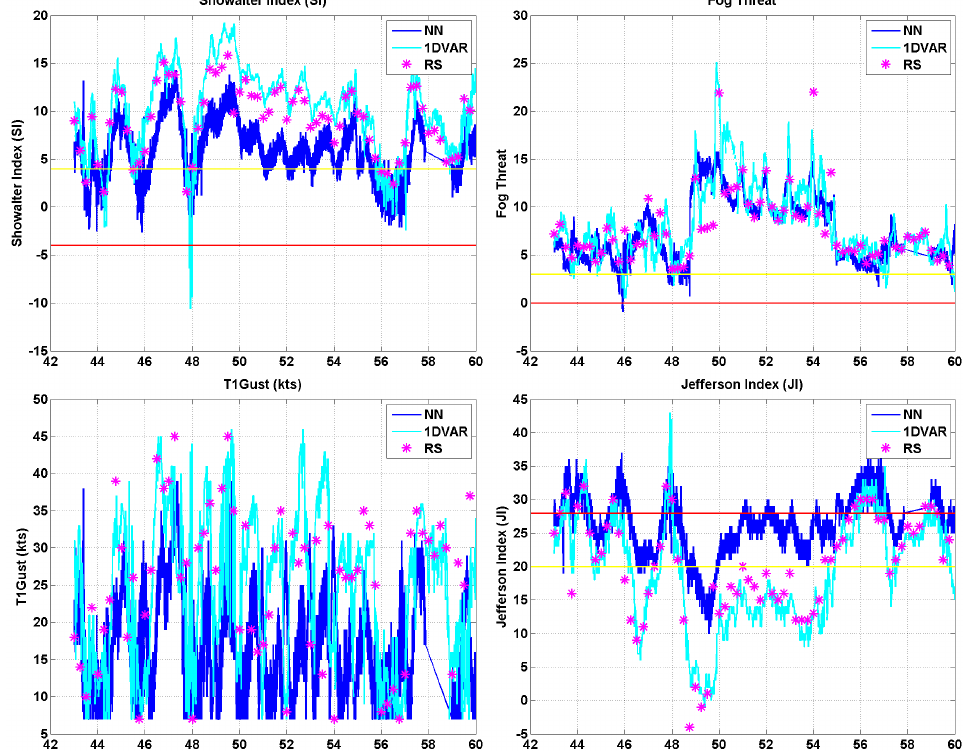
Figure 6. As in Fig. 3 but for (clockwise from top-left panel) Showalter index, fog threat, T1 gust, and Jefferson index. The horizontal yellow and red lines indicate thresholds for moderate and high potential, respectively (where